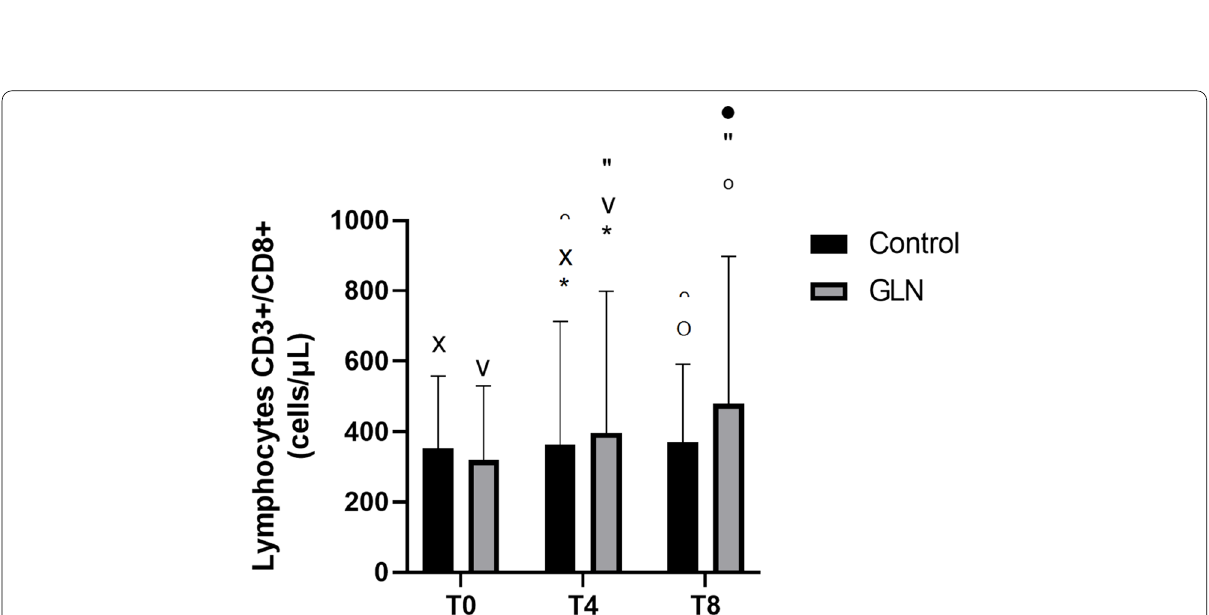
Fig. 3 CD3 /CD8 T suppressor lymphocyte levels in control and glutamine (GLN) groups. Data are presented as mean + + significant difference in GLN vs control at T4 ( p < 0.05) and at T8 ( p < 0.001); ˅ , ”, and • indicate statistically significant ( p < 0.001) in the GLN group; x and indicate a significant difference in the control group between T0 and T4 ( p < 0.001) and T4 and T8 ( p ∩